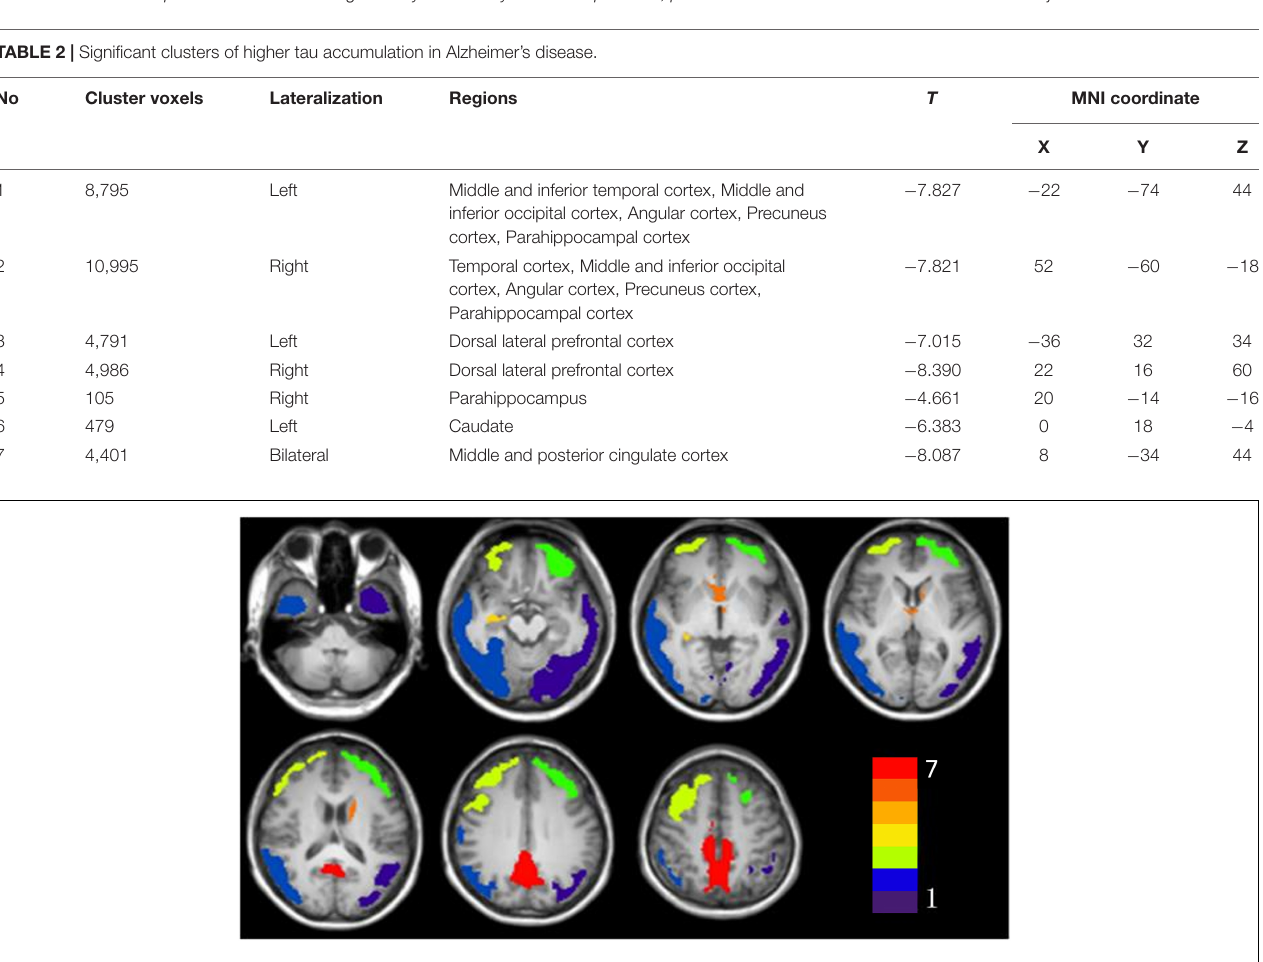
FIGURE 1 | The significant clusters of tau accumulation in Alzheimer’s disease patients. The color bar indicates the different clusters (Cluster 1 to Cluster 7).